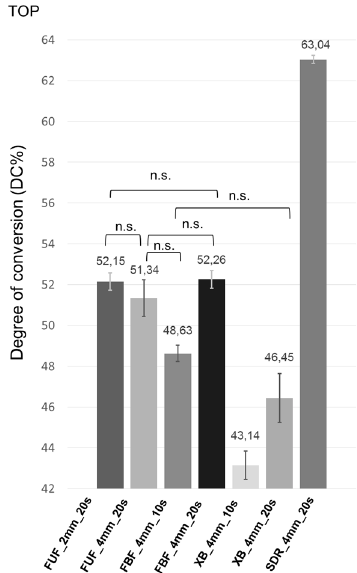
Figure 1. Mean DC% and 95% confidence intervals of the top surface of the samples (abbreviations: DC,